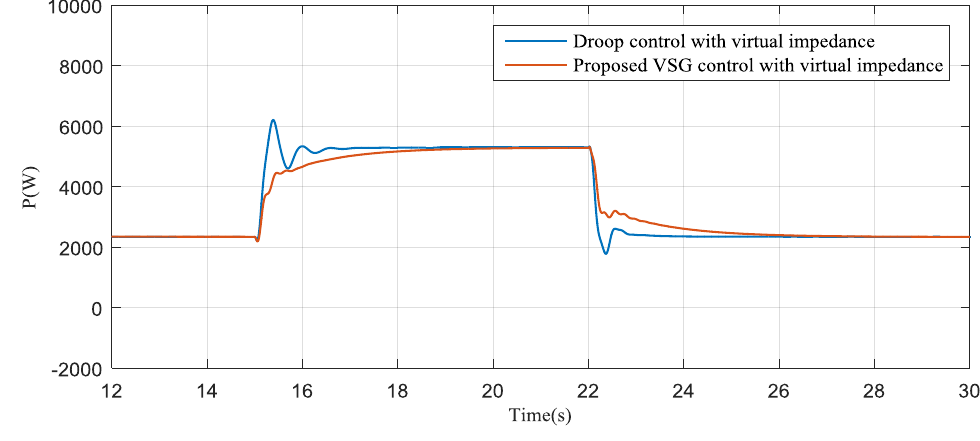
Figure 25. Active power of the grid-feeding converter.